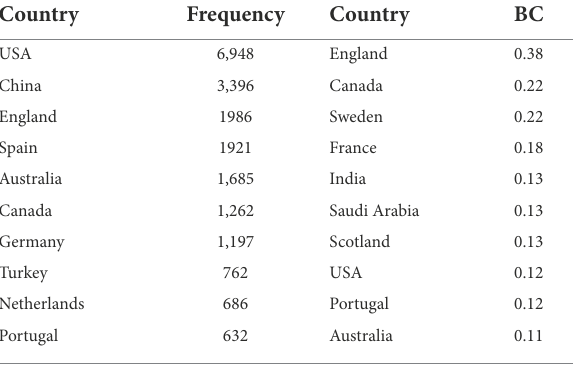
TABLE 2 Top 10 countries based on frequency and